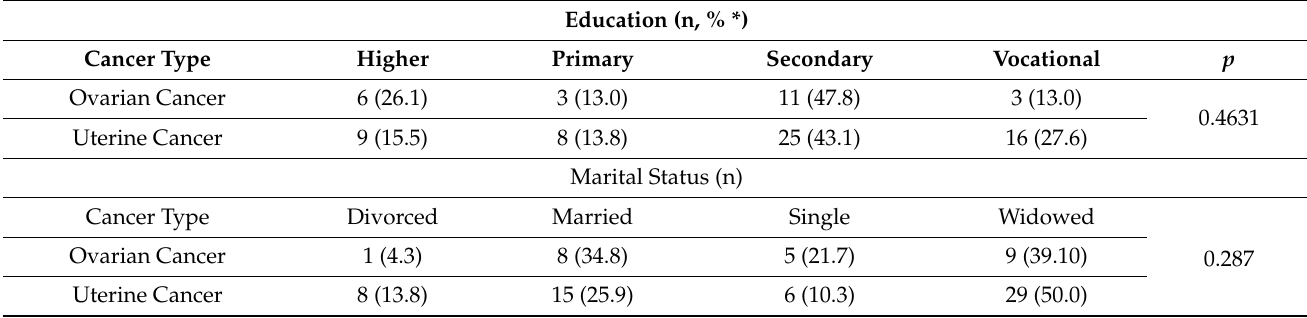
Table 1. Sociodemographic data with regard to the type of